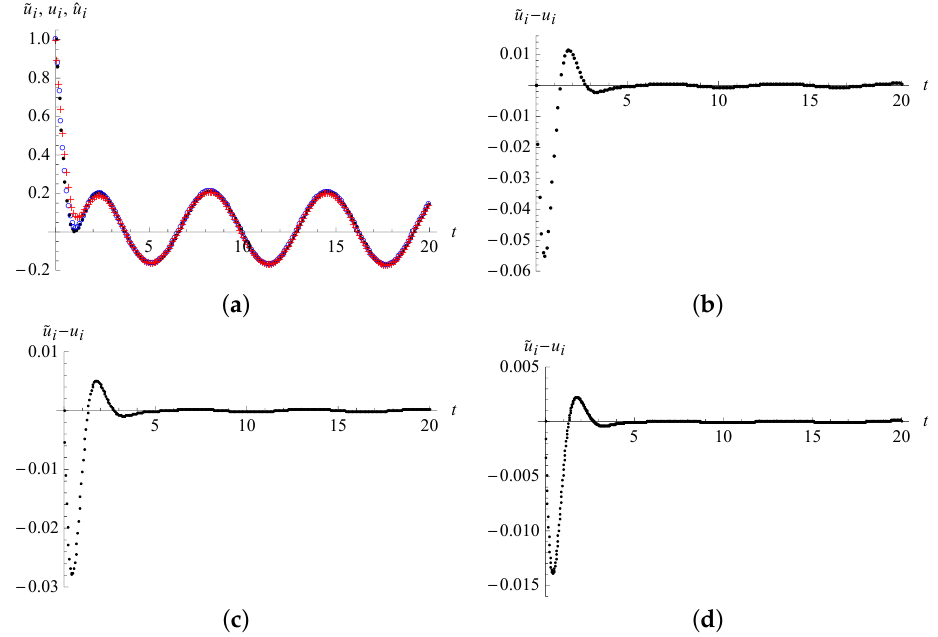
Figure 3. The numerical solutions and comparisons in Example 2. ( a ) The numerical solutions with h = 0.1 by the inverse Laplace transform, ˜ u i (dots), the quadratic spline interpolation u i (circles) and the L 1– L 2 methods ˆ u i (crosses); ( b ) the differences of the two numerical solutions ˜ u i and u i ( h = 0.1); ( c ) the differences of the two numerical solutions ˜ u i and u i ( h = 0.05); ( d ) the differences of the two numerical solutions ˜ u i and u i ( h = 0.025).